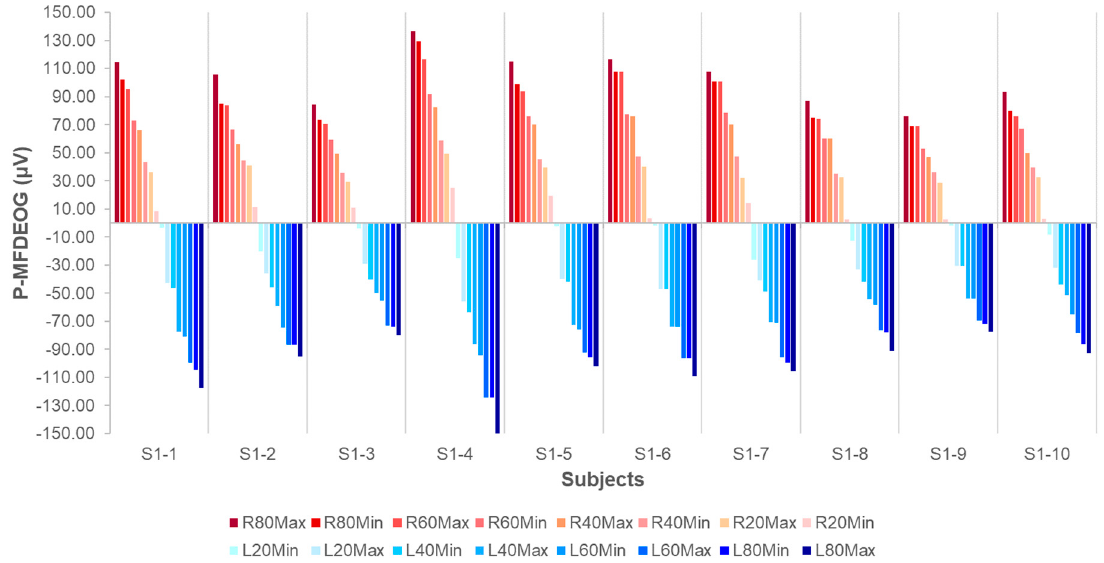
Figure 7. Comparison of the maximum and minimum of p-MFDEOG for 10